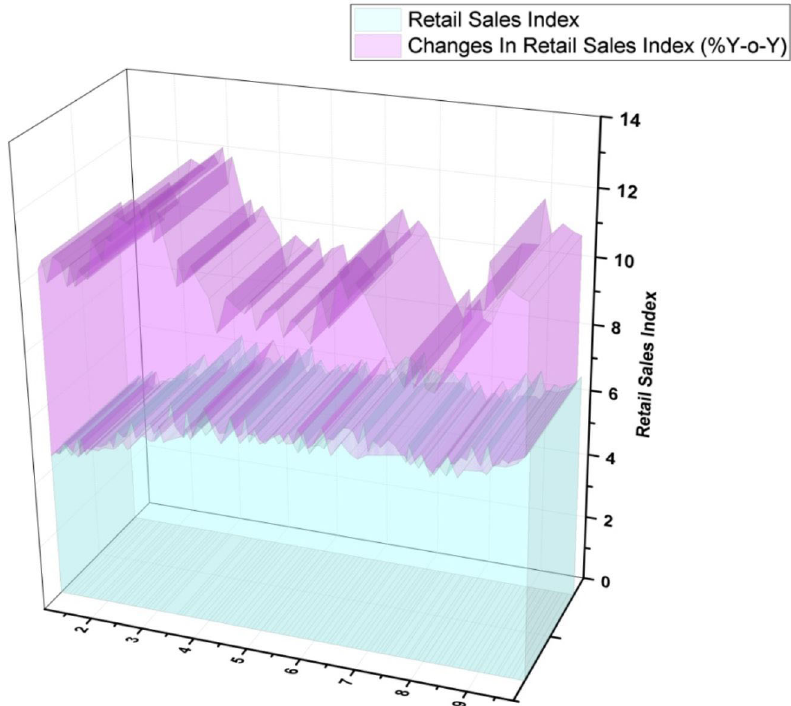
Figure 6. Thailand retail sales index.